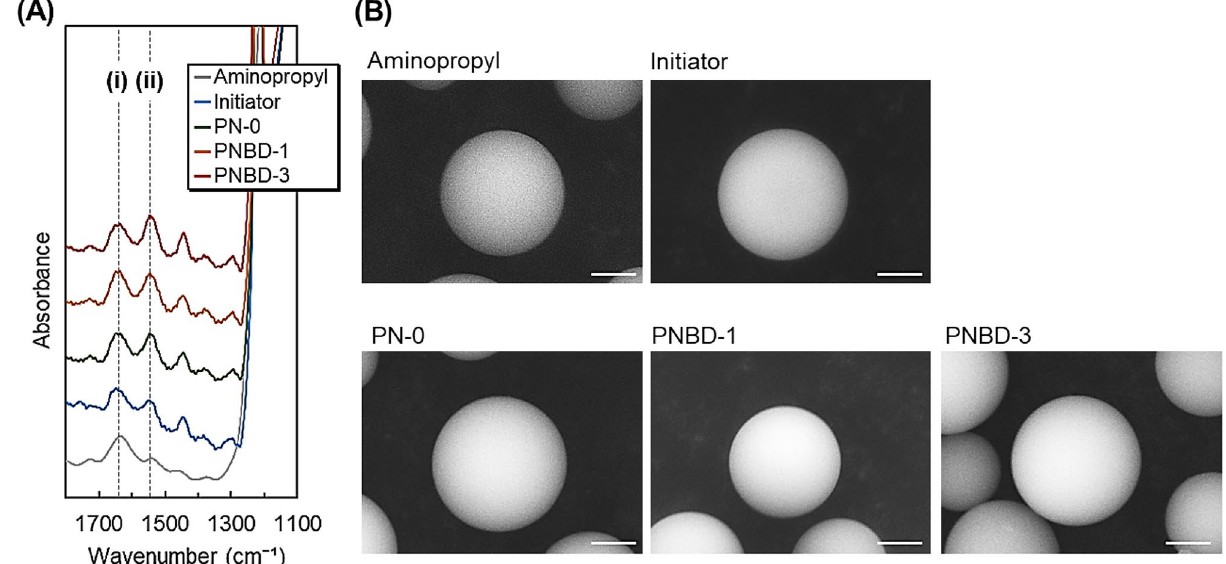
Figure 2. ( A ) FT-IR spectra and ( B ) SEM images of the prepared beads. Scale bar: 2